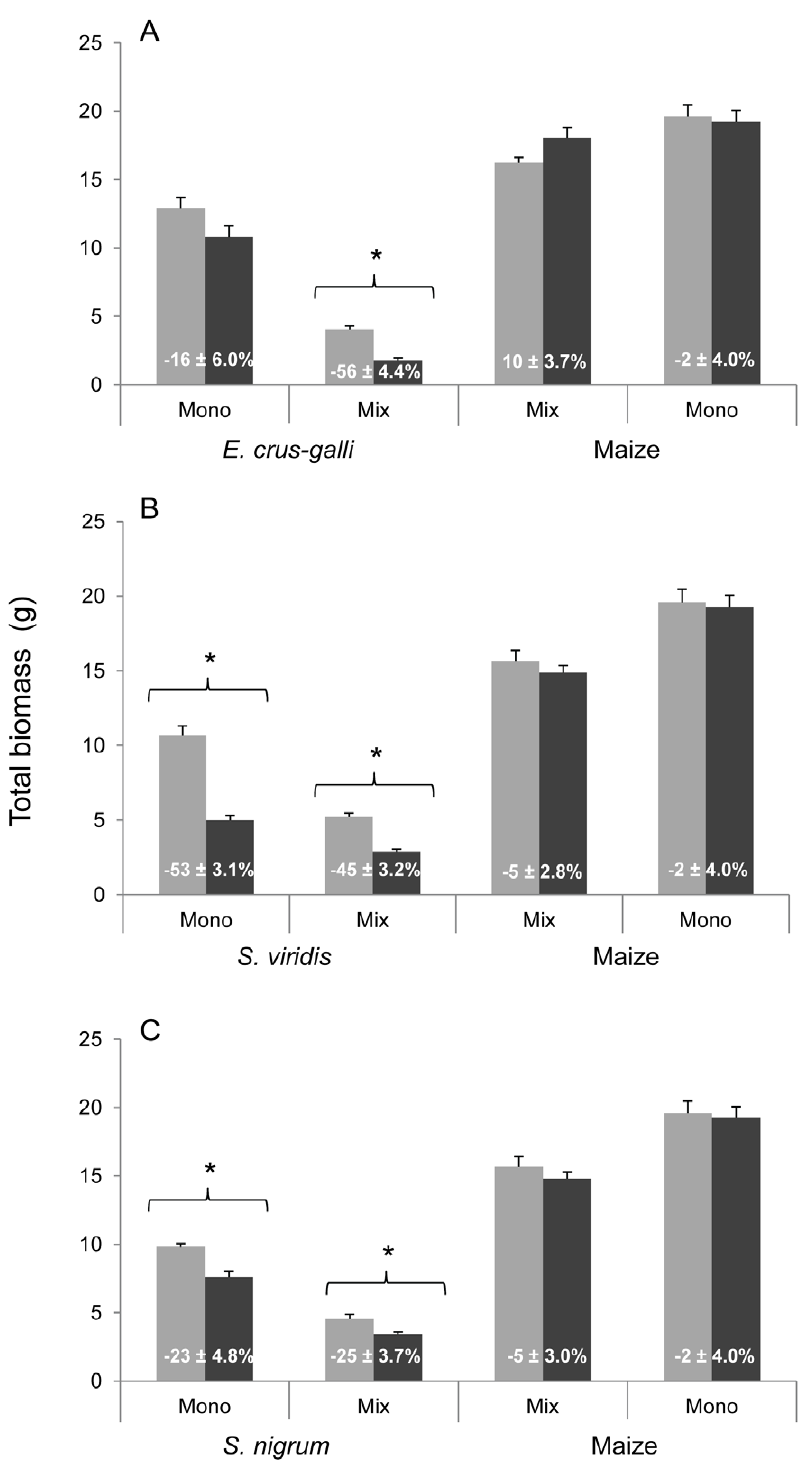
Figure 3. Total biomass (g) of the three weed species and maize in experiment 2. Plant species were grown alone (Mono) or in weed-maize combinations (Mix). Monocultures and mixtures of E. crus-galli and maize ( A ), S. viridis and maize ( B ) and S. nigrum and maize ( C ) were inoculated with AMF (black bars) or with NM control inoculum (grey bars). Bars are means of seven replicates 6 SEM. Asterisks represent significant differences in total biomass between the AMF treatment and NM control for each species, in monocultures or mixtures. Total biomass of maize in monoculture repeated in each graph for better visual interpretation. Values in white inserted in the bars indicate the mycorrhizal growth response (%) of each species, in monocultures or mixtures (mean of seven replicates 6 SEM).